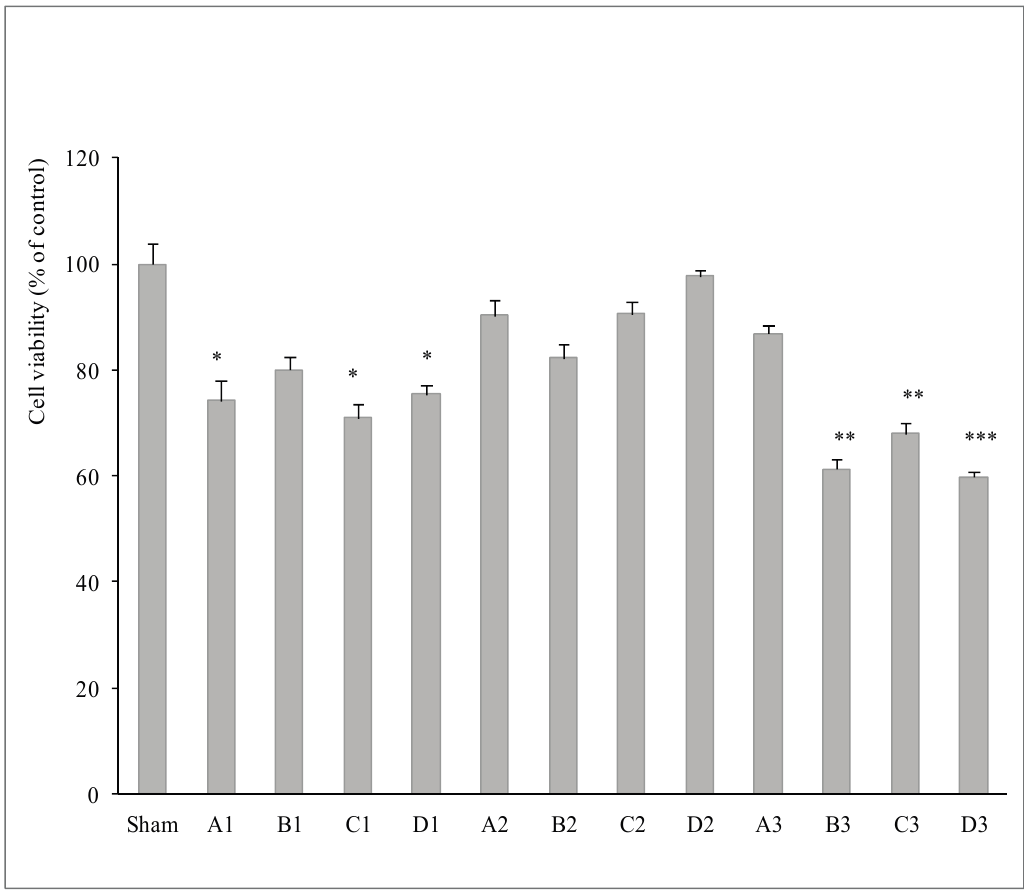
Figure 2. Percentage of viability ± SD in H727 exposed at 70 μ g/mL of environmental solutions for 6 h by MTT assay. A = Fraction 2.5–10 µm; B = Fraction 1–2.5 µm; C = Fraction 0.5–1 µm; D = 0.25–0.5 µm. Site 1 = platform; Site 2 = commercial-intermediate area; Site 3 = outdoor. * p < 0.05, ** p < 0.01, *** p < 0.001 vs. untreated cells